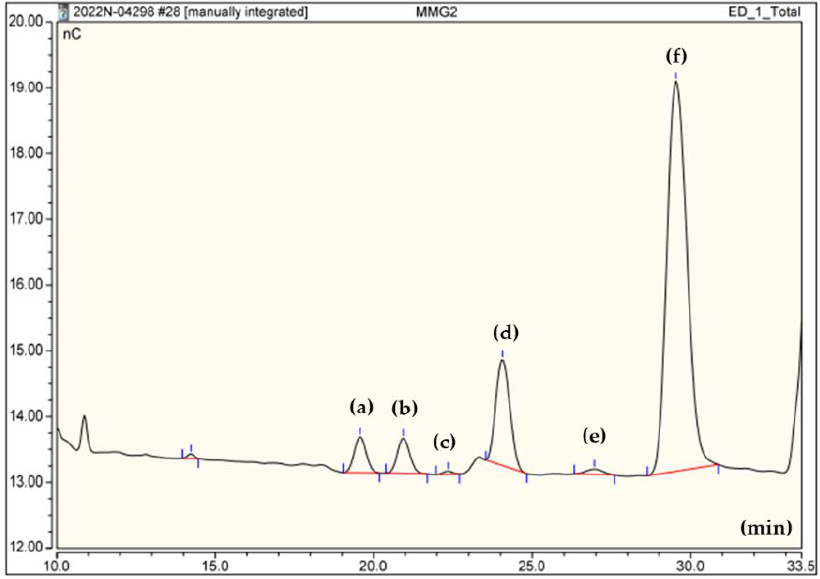
Figure 2. Assessment of monosaccharide composition of EPS produced by Lysobacter sp. MMG2 (lyEPS) by Bio-LC (Dionex ICS-5000PC. ( a ) Arabinose (19.592), ( b ) galactose (20.942), ( c ) rhamnose (22.292), ( d ) glucose (24.067), ( e ) xylose (26.926), and ( f ) mannose (29.567). The retention time for absorption peaks is indicated in parentheses in minutes. The monosaccharide composition of lyEPS was in the following descending order: mannose, glucose, galactose, arabinose, xylose, and rhamnose.